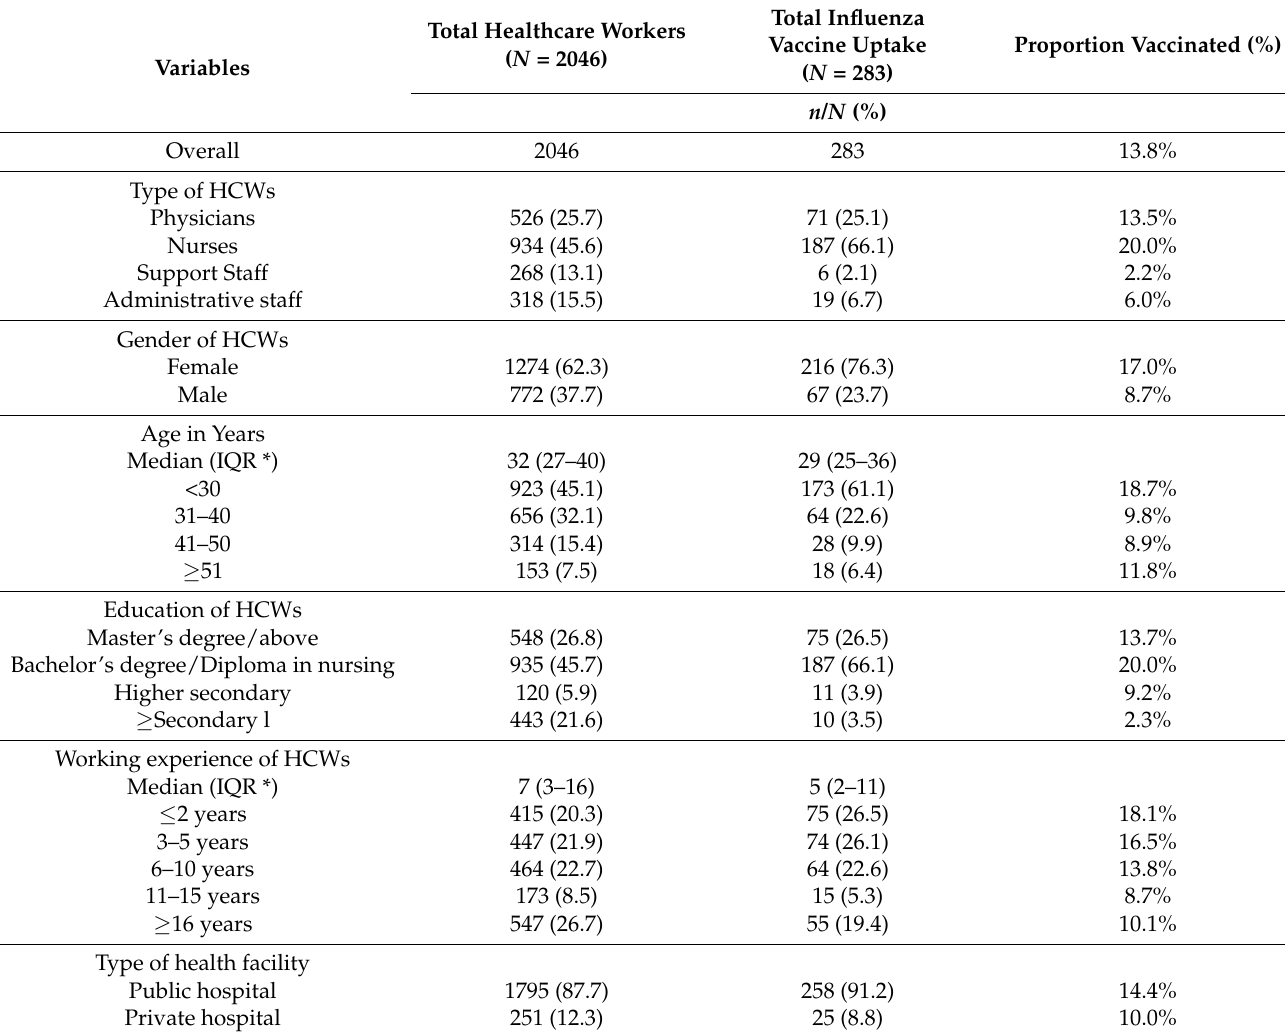
Table 1. Basic characteristics of study